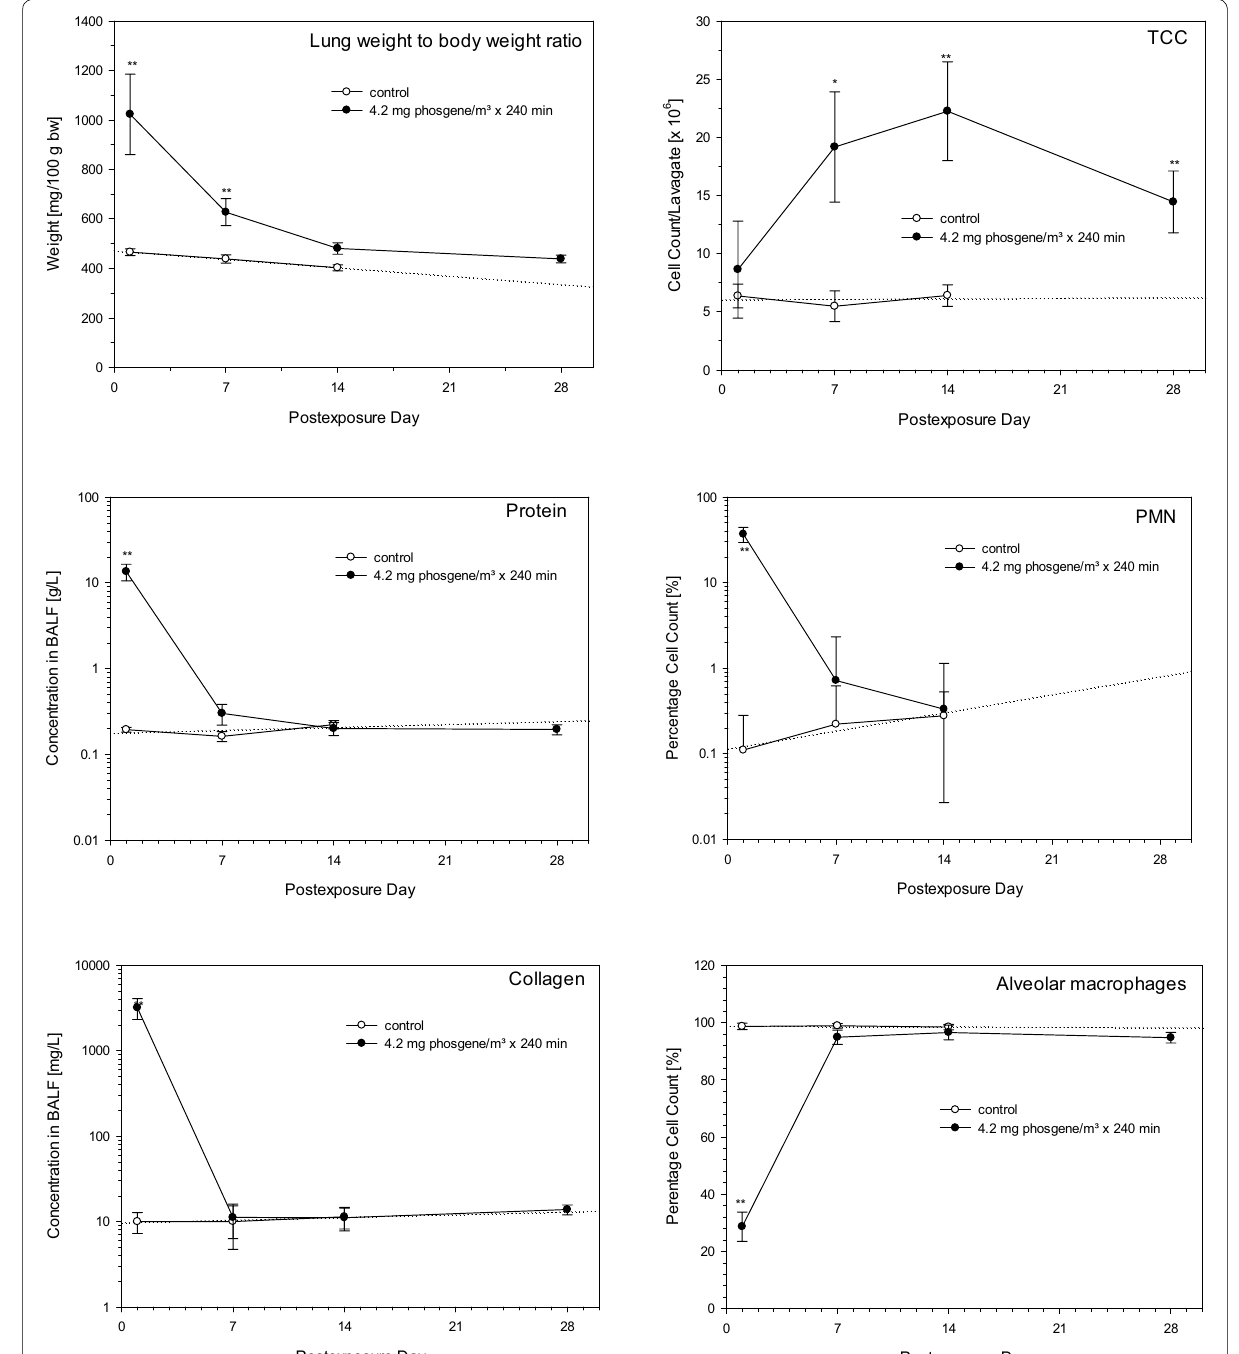
Fig. 3 The left column compares time-course changes of endpoints suggestive of pulmonary edema (protein and soluble collagen in BALF, wet weight of excised lungs). Associated changes in cellular endpoints (TCC, PMN and alveolar macrophages in BALF) are shown in the right column . Rats were exposed to air (control) or phosgene at the non-LCt 01 of on post-exposure days 1, 7, 14, and 28 (phosgene only). Data points represent means significant differences to the time-matched air control group (*P < 0.05, **P <